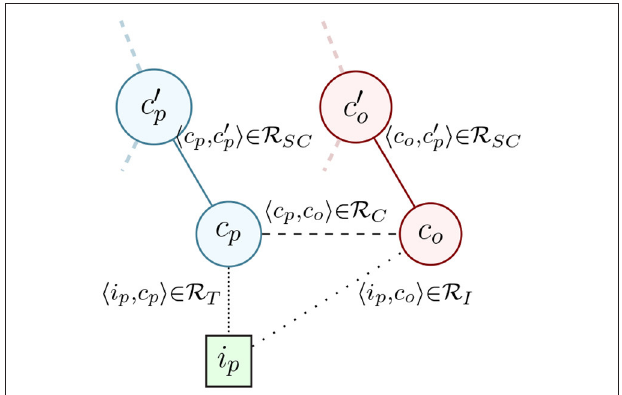
FIGURE 2 | Example subset of graph G with a place instance i p , a place category c p , its parent category c ′ p , a offering category c o , its parent c ′ o and the class- and instance- level offering availability relations between